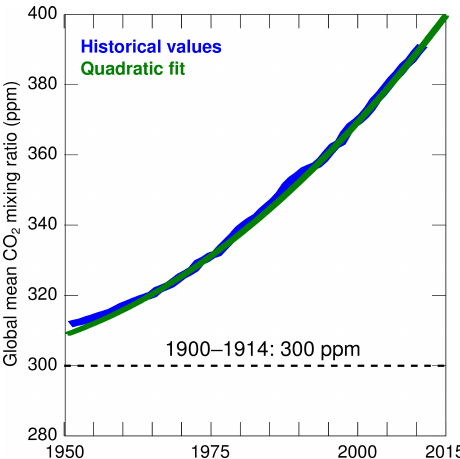
Figure 2. CO 2 mixing ratio used in the numerical experiments (green; see Methods section). The historical values (blue) are from Miller et al. (2014). The dashed line represents the constant value assumed in the experiments of